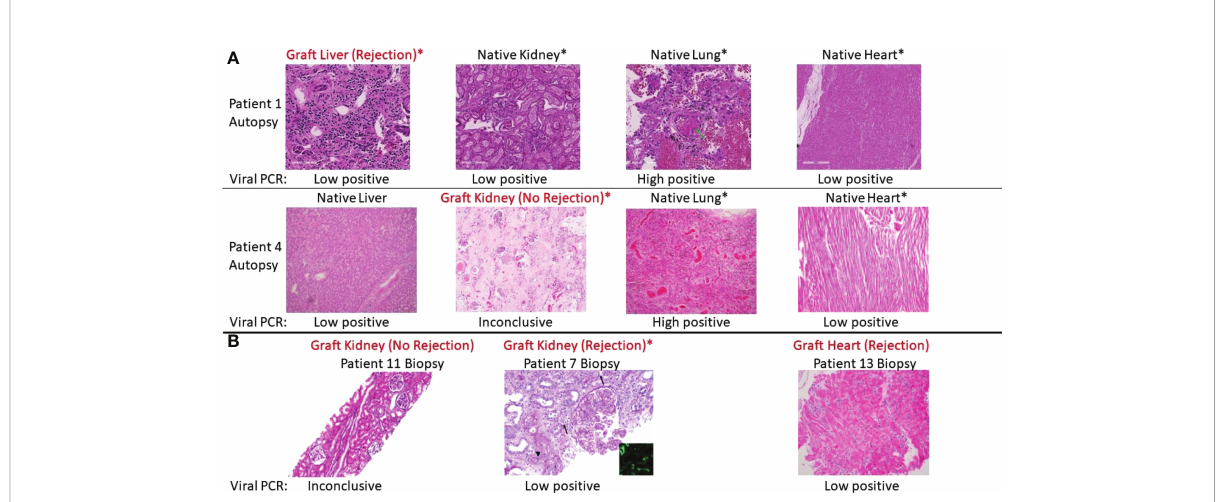
FIGURE 1 Representative histologic appearances of tissue from transplant patients with SARS-CoV-2 infection, including grafts with and without rejection. Viral PCR positivity is also shown below each picture. Asterix (*) indicates organ dysfunction as assessed by lab values or lack of function (e.g., requiring dialysis). (A) Various tissues (hematoxylin and eosin [H&E] stain) from autopsy of Patient 1, who had rejection of the liver graft during SARS-CoV-2 infection, and Patient 4, who did not have rejection of the kidney graft during SARS-CoV-2 infection. Patient 1 from left to right: graft liver with mild in fl ammation and periportal fi brosis consistent with acute cellular rejection. Native kidney with autolysis and tubular degenerative changes. Native lung with diffuse alveolar damage (green arrow), congestion, platelet aggregation, and hemorrhage. Native heart no in fl ammation. Patient 4 from left to right: native liver with centrilobular congestion. Graft kidney with ischemic changes and fi brosis but without signi fi cant in fl ammatory in fi ltrate. Native lung with congestion and focal in fl ammation. Native heart with mild chronic pericarditis (not captured in this image) but no interstitial in fl ammation. (B) Representative graft biopsies with and without rejection. From left to right: Patient 11 graft kidney showing tubules without signi fi cant in fl ammation (Jones methenamine silver). Patient 7 graft kidney with global endocapillary hypercellularity (transplant glomerulitis), peritubular capillaritis (arrows), and severe arteritis (arterial fi brin; arrowhead) (periodic acid – Schiff). These fi ndings are accompanied by focal C4d staining in peritubular capillaries (inset, immuno fl uorescence staining for C4d, original magni fi cation ×400). Patient 13 graft heart with perivascular lymphocytic in fi ltration consistent with